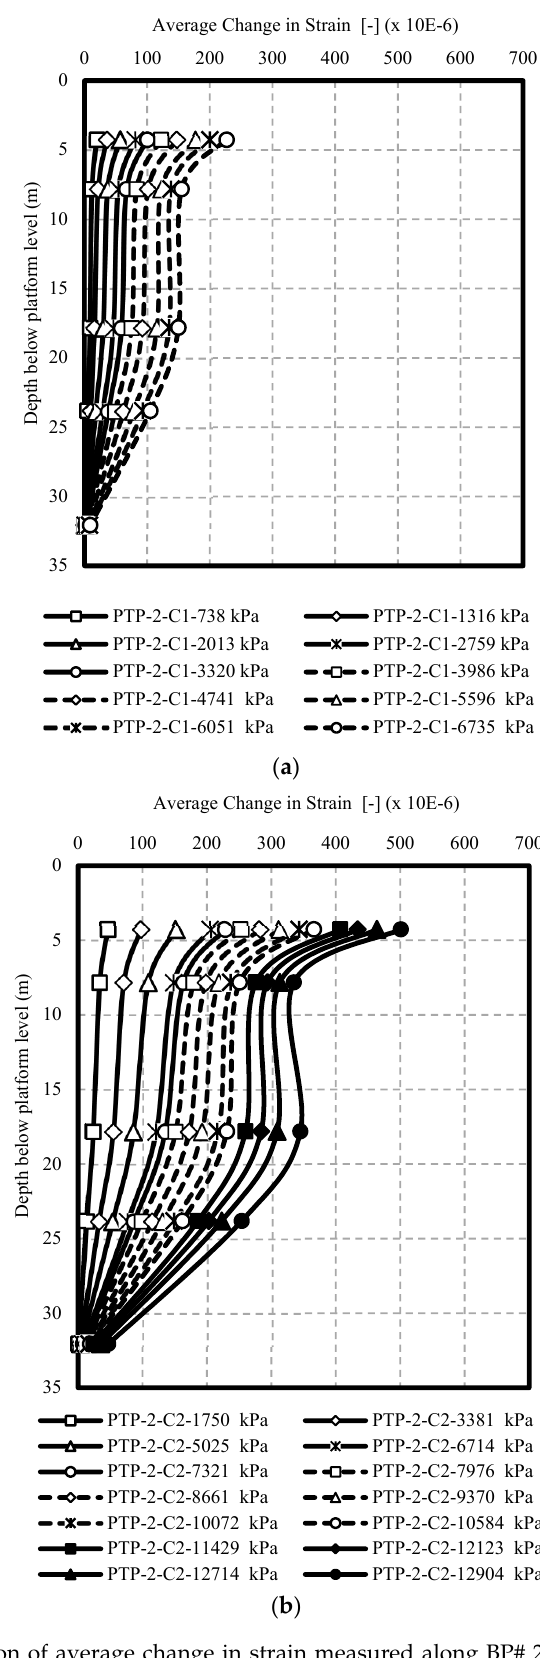
Figure 14. Distribution of average change in strain measured along BP# 2 in ( a ) 1st cycle and ( b ) 2nd cycle.